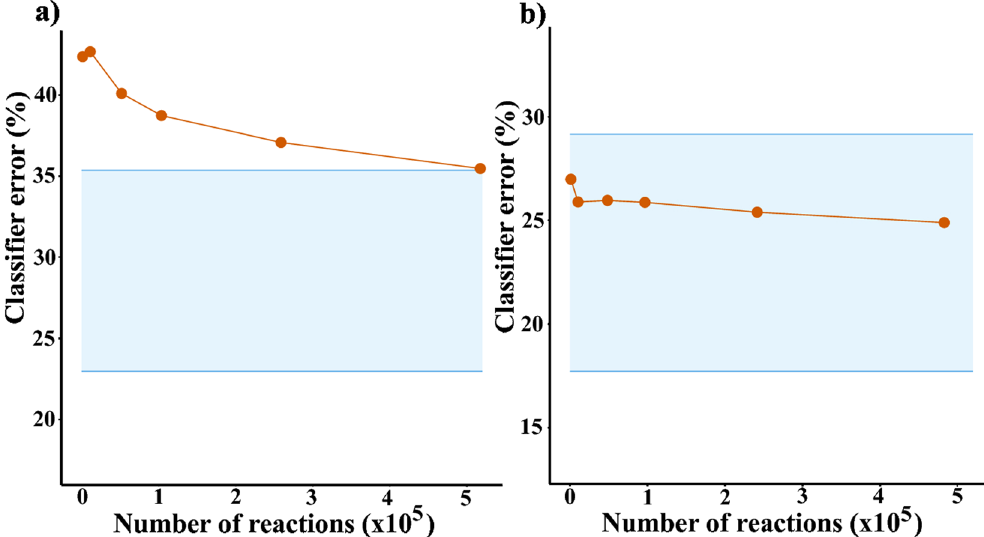
Figure 4. Classifier performance for Random Forests built on reaction fingerprints. Errors – both for ( a ) yields and ( b ) times – do not significantly decrease for large datasets. Blue, shaded regions demarcate lower and upper estimates for the Bayes classifier